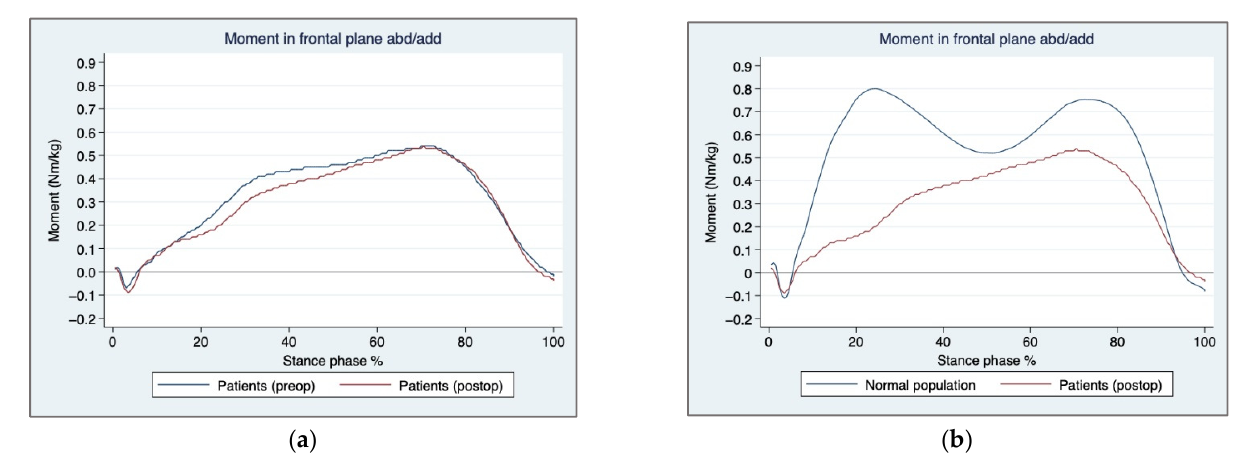
Table 2. Gait parameters in 15 controls and 15 patients undergoing gluteus maximus transfer pre- and postoperatively at the two-year follow-up.